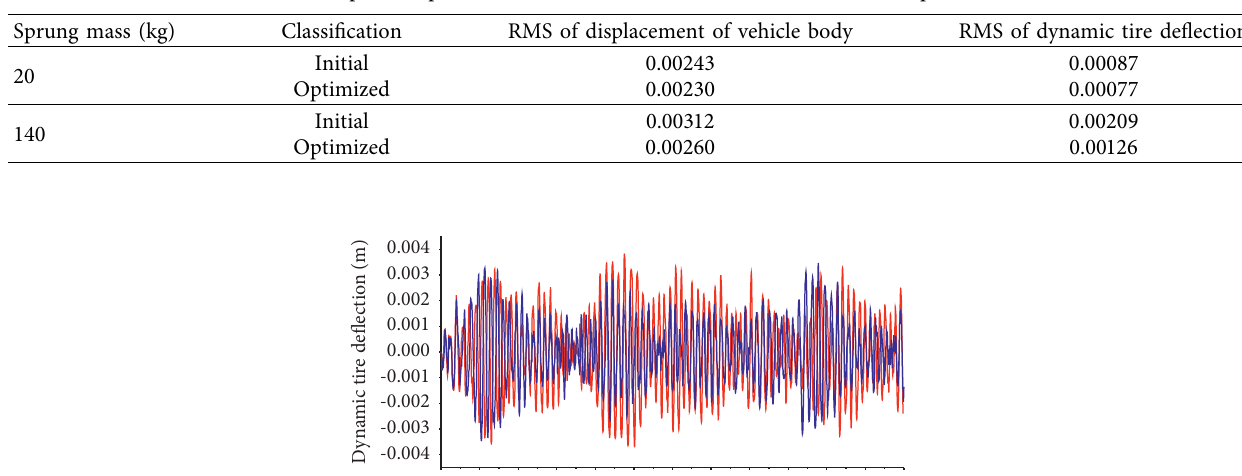
Table 4: Suspension parameters and evaluation indexes before and after optimization.